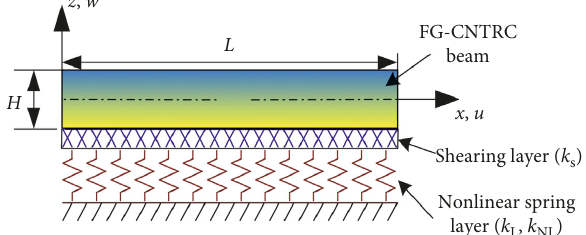
Figure 1: Geometry and notations of the FG-CNTRC beam interacting with nonlinear elastic foundations.